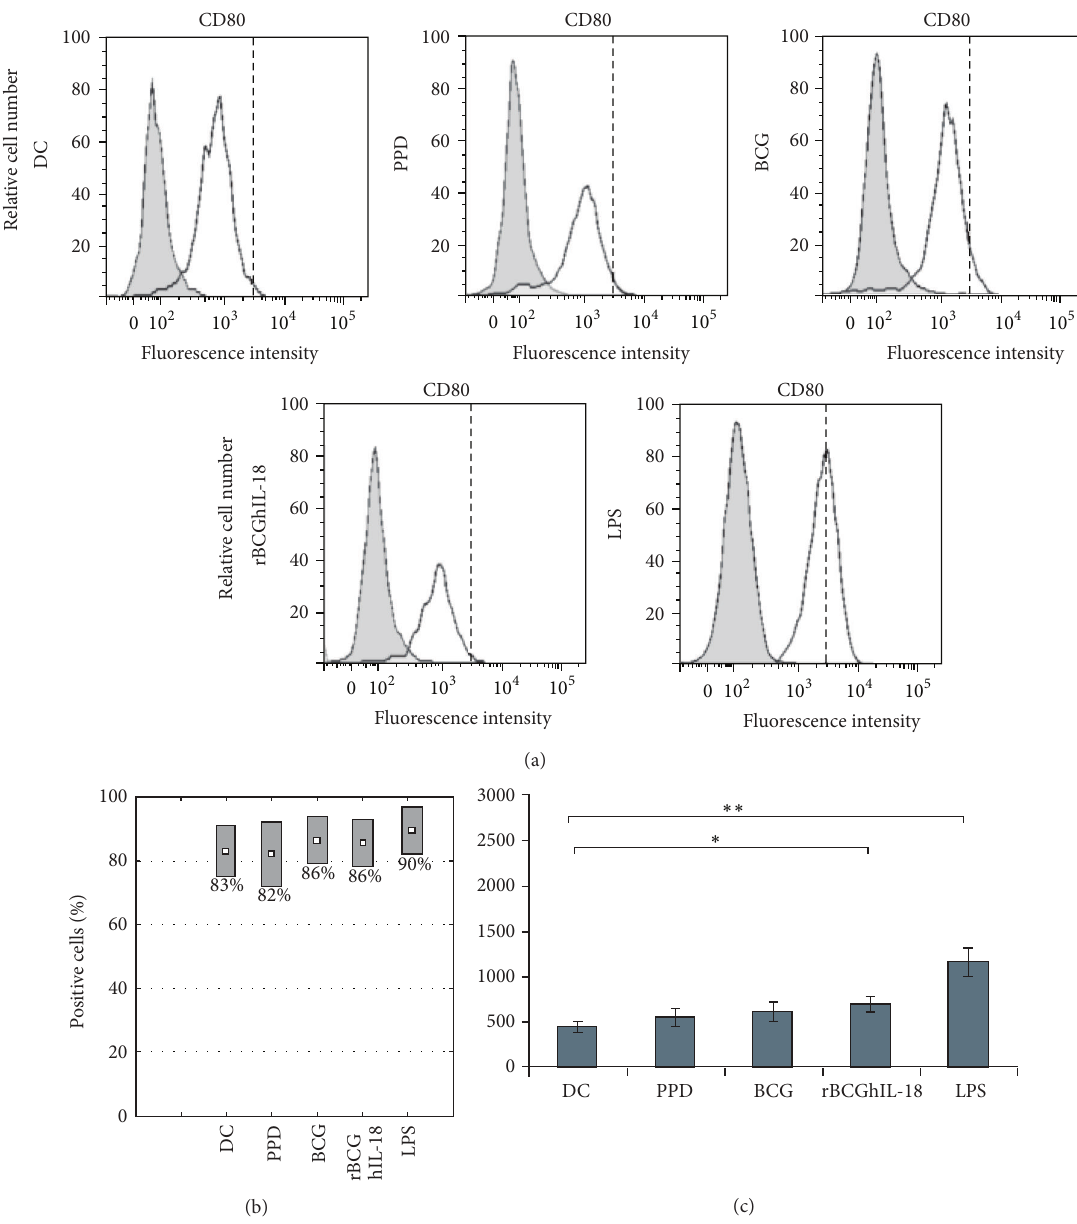
Figure 4: CD80 surface expression of MoDCs. Human MoDCs were pulsed either with PPD (10 𝜇 g/mL), BCG (1: 1), rBCGhIL-18 (1:1), or LPS (1 𝜇 g/mL) for 24 h or were left unstimulated (DC). (a) One representative experiment out of 20 independent ones is shown. Grey histograms represent the cell reactivity to fluorochrome-matched isotype control antibodies. The white histograms represent the reactivity with the anti-CD80 antibody. The vertical broken lines represent the upregulation obtained by LPS stimulation; (b) percentage of positive cells with the CD80 expression; (c) median fluorescence intensity (MFI) values (median ± SEM of 20 independent donors). Fluorescence intensity was calculated by the MFI of the receptor expression from which the MFI obtained with a nonrelevant, isotype-matched antibody was substracted. Statistical analyses were performed using the Kruskal-Wallis test. ∗ 𝑃 < 0.05 ; ∗∗ 𝑃 < 0.01